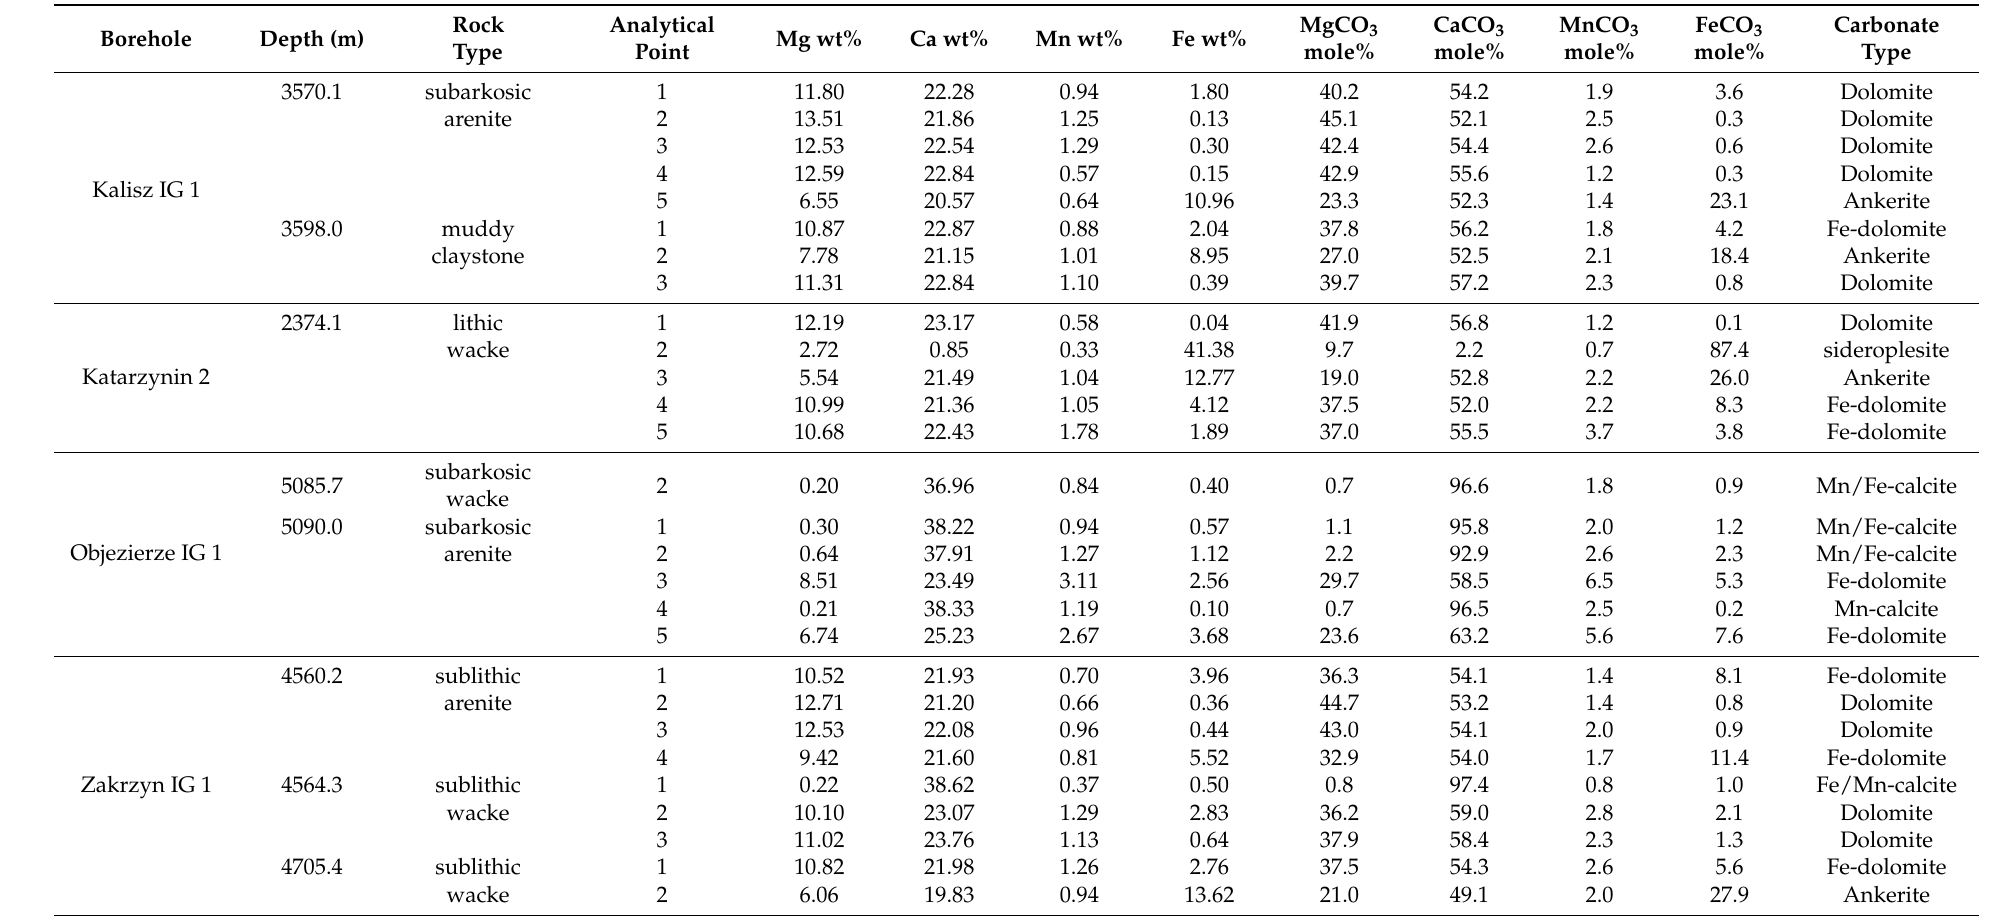
Table 2. The results of the electron microprobe analysis of